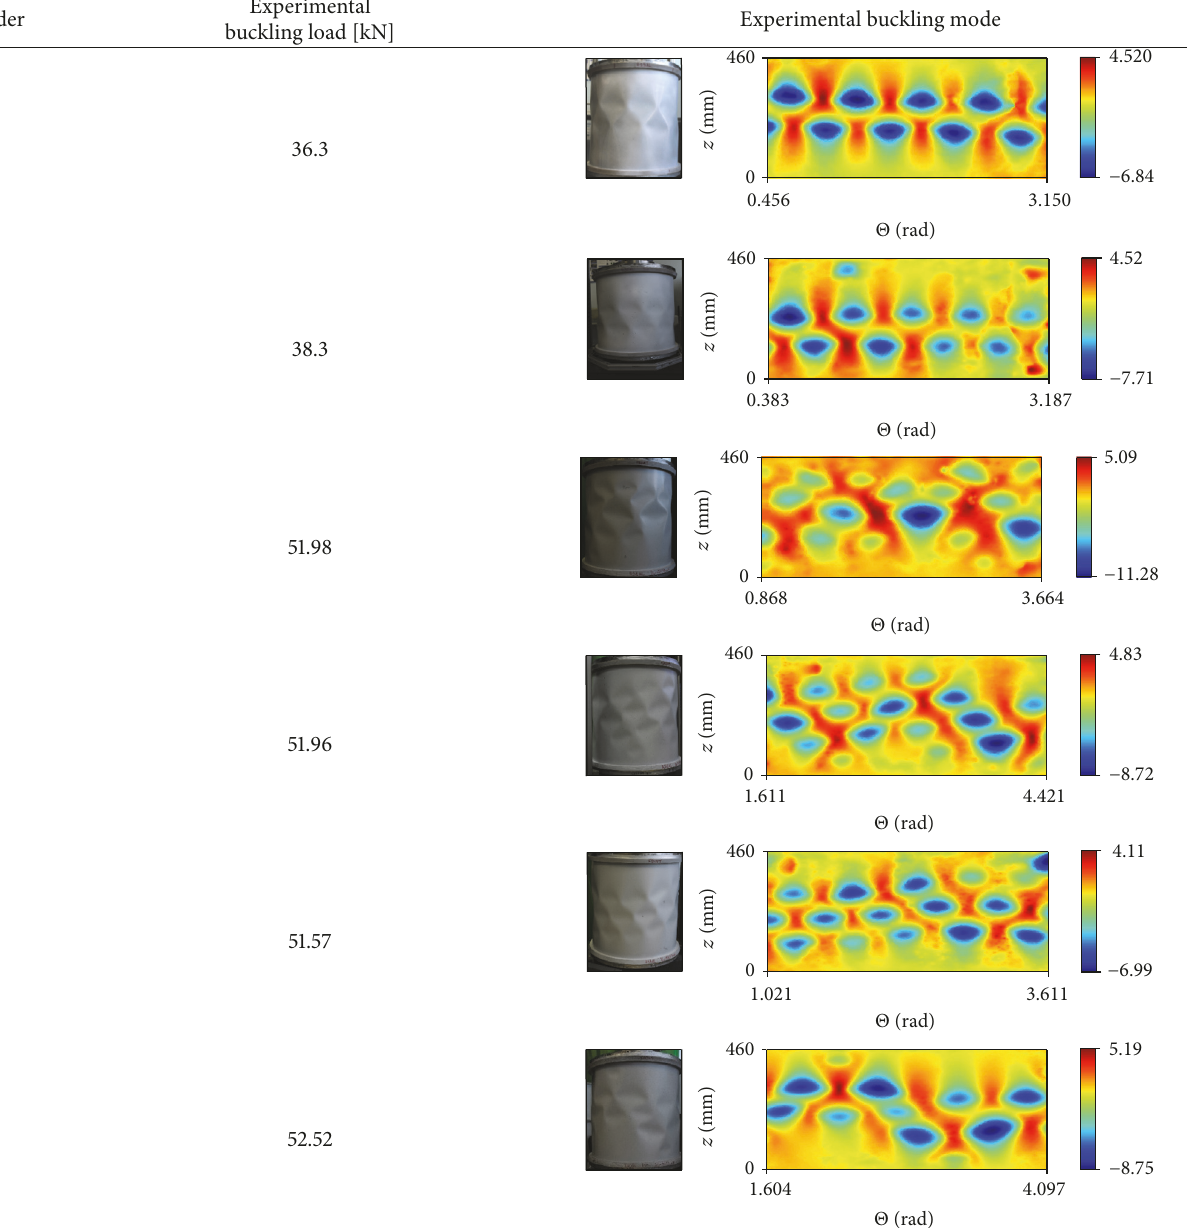
Table 2: Experimental buckling loads and mode shapes of intact